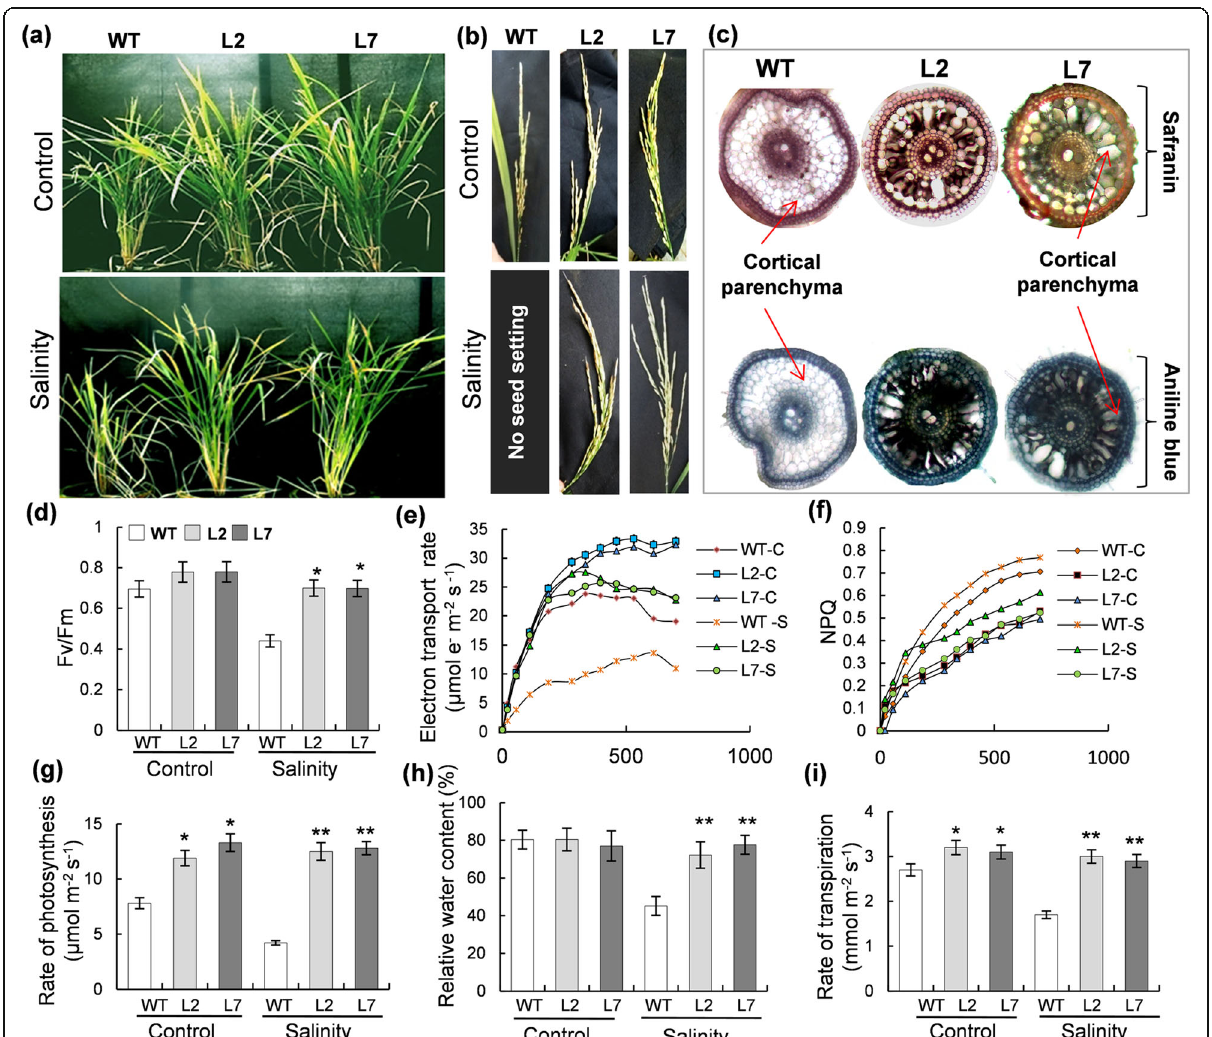
Fig. 5 Assessment of physiological and morphological parameters of mature OsHBP1b lines as compared to the WT under salinity. a Pictorial view of mature WT and OsHBP1b over-expressing plants. Note the better growth in terms of plant height, and number of leaves in the OsHBP1b over-expressing plants as compared to WT under both control and salinity conditions. b Panicle morphology of WT and OsHBP1b over-expressing plants. Note that under salinity, there was no panicle produced in the WT plants. c Anatomy of the root of WT and OsHBP1b over-expressing plants stained with safranin (upper panel) or aniline blue (lower panel) under control conditions. d Fv/Fm, ( e ) electron transport rate, ( f ) NPQ, ( g ) rate of photosynthesis, ( h ) relative water content and ( i ) rate of transpiration, in OsHBP1b over-expressing plants as compared with the WT. Error bars show standard error from triplicate experiments. Single asterisk show significant difference at p < 0.005 and double asterisk at p <